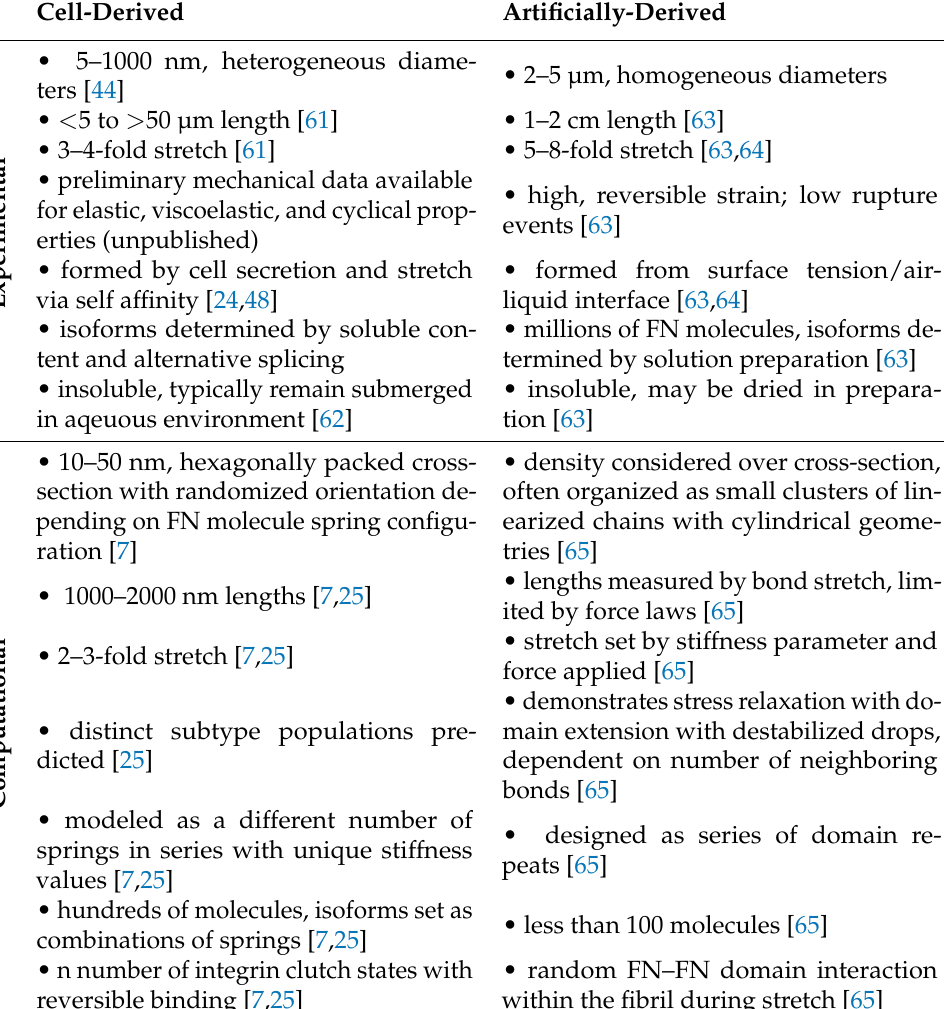
Table 1. Properties of Experimentally Observed and Computationally Predicted FN fibrils. Both cell-derived and artificially derived FN fibrils have been studied in vitro, but there are observable differences between the two. Computational models of both cell-derived and artificial fibrils have been developed, with distinct approaches and